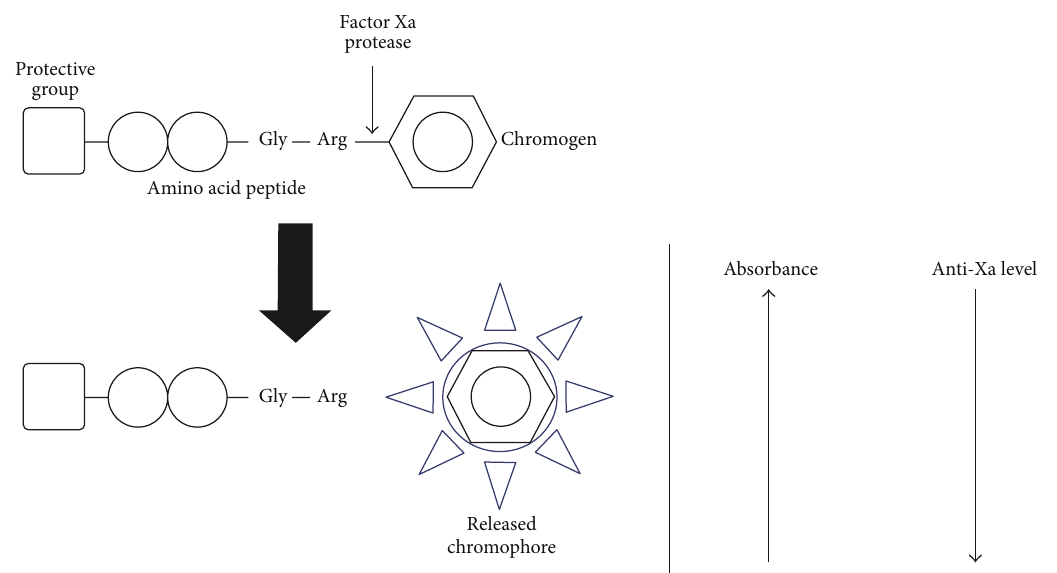
Figure 2: Chromogenic anti-Xa method. Factor Xa cleaves the synthetic chromogenic substrate to release a chromophore, quantified by spectrophotometry absorbance. Absorbance is proportional to factor Xa activity and inversely proportional to anti-Xa